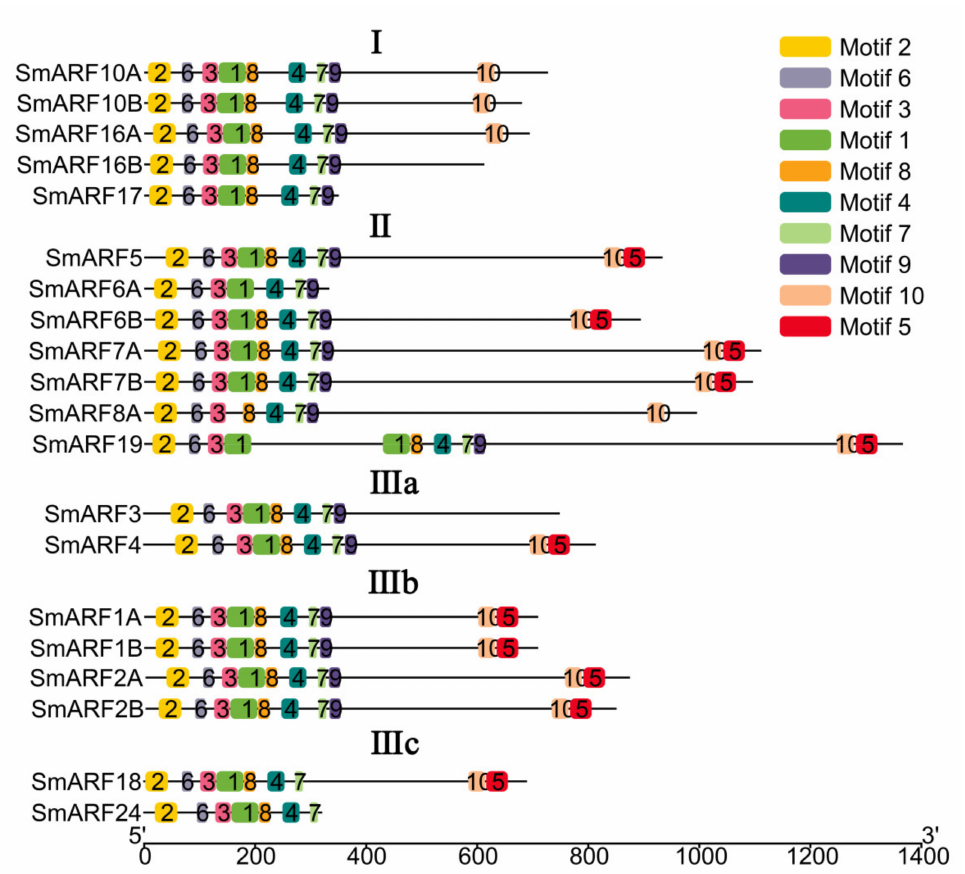
Figure 3. Schematic representation of conserved motifs in auxin response factor proteins in eggplant ( Solanum melongena L.). The horizontal scale indicates protein length (number of amino